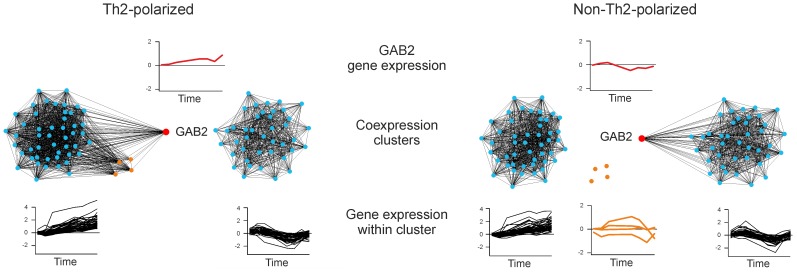
Switching pattern for GAB2 in human T helper 2 cell differentiation (Th2) dataset, detected by DCeN.Co-expression clusters, visualized here using Cytoscape, contain those genes with the largest difference in co-expression with GAB2 between the two experiments (top 0.5%). Connecting edges indicate strong correlation (co-expression weight>0.95). Co-expression of GAB2 with other genes switches between different co-expression clusters, depending on whether polarization towards Th2 was induced or not.